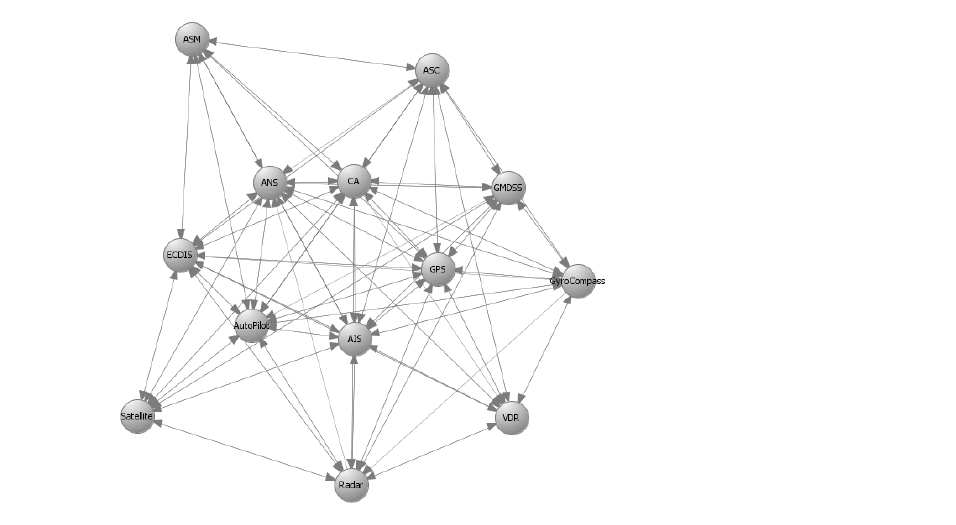
Figure 3. Autonomous ship—Navigational Cyber-Physical Systems (CPSs)– G I ( V , E ) –Information flow connections.